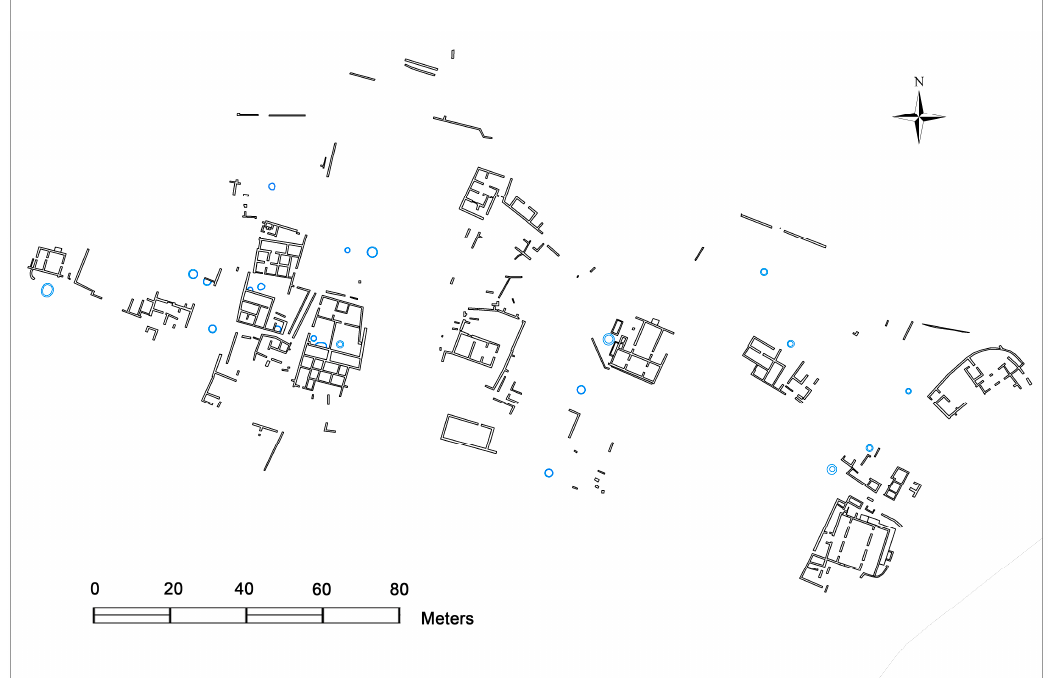
Figure 3. The layout plan of Jumba la Mtwana showing the location of wells and cisterns in